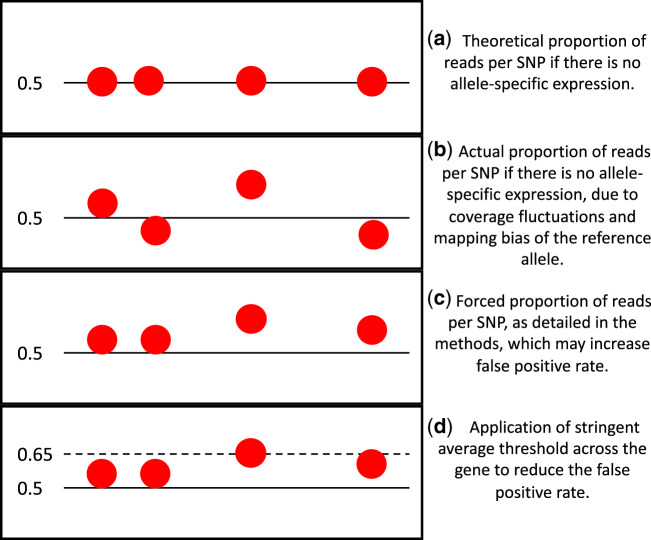
Overview of the theoretical proportions of reads per SNP in a gene which does not show allele-specific expression. Each red dot is an individual SNP.